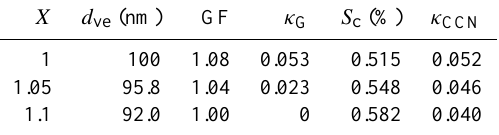
Table 1. Volume equivalent diameters ( d ve ) , calculated hygro- scopic growth factors (GF) at 85% RH, calculated critical super- saturation ( S c ) and hygroscopicity parameters κ G and κ CCN of par- ticles with a mobility diameter of d m = 100nm and various shape factors X = { 1 . 00 , 1 . 05 , 1 . 10 } . The particles are assumed to consist of 30% levoglucosan and 70% insoluble material by volume. The 0.01 difference in κ G and κ CCN is most likely caused by slightly different Koehler approximations in modeling the idealized particle and the κ -Koehler